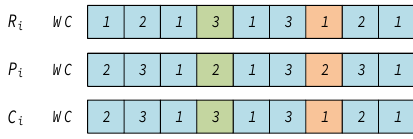
R . Figure 6 depicts the WC updating pro- i